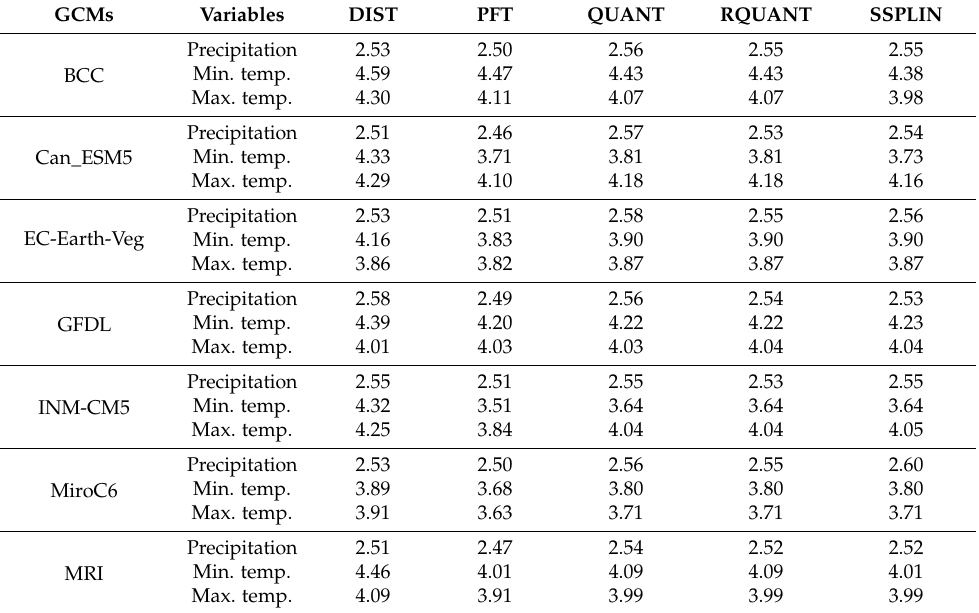
Table 4. MAE of five bias-correction methods for observed versus corrected daily data (1985–2014).